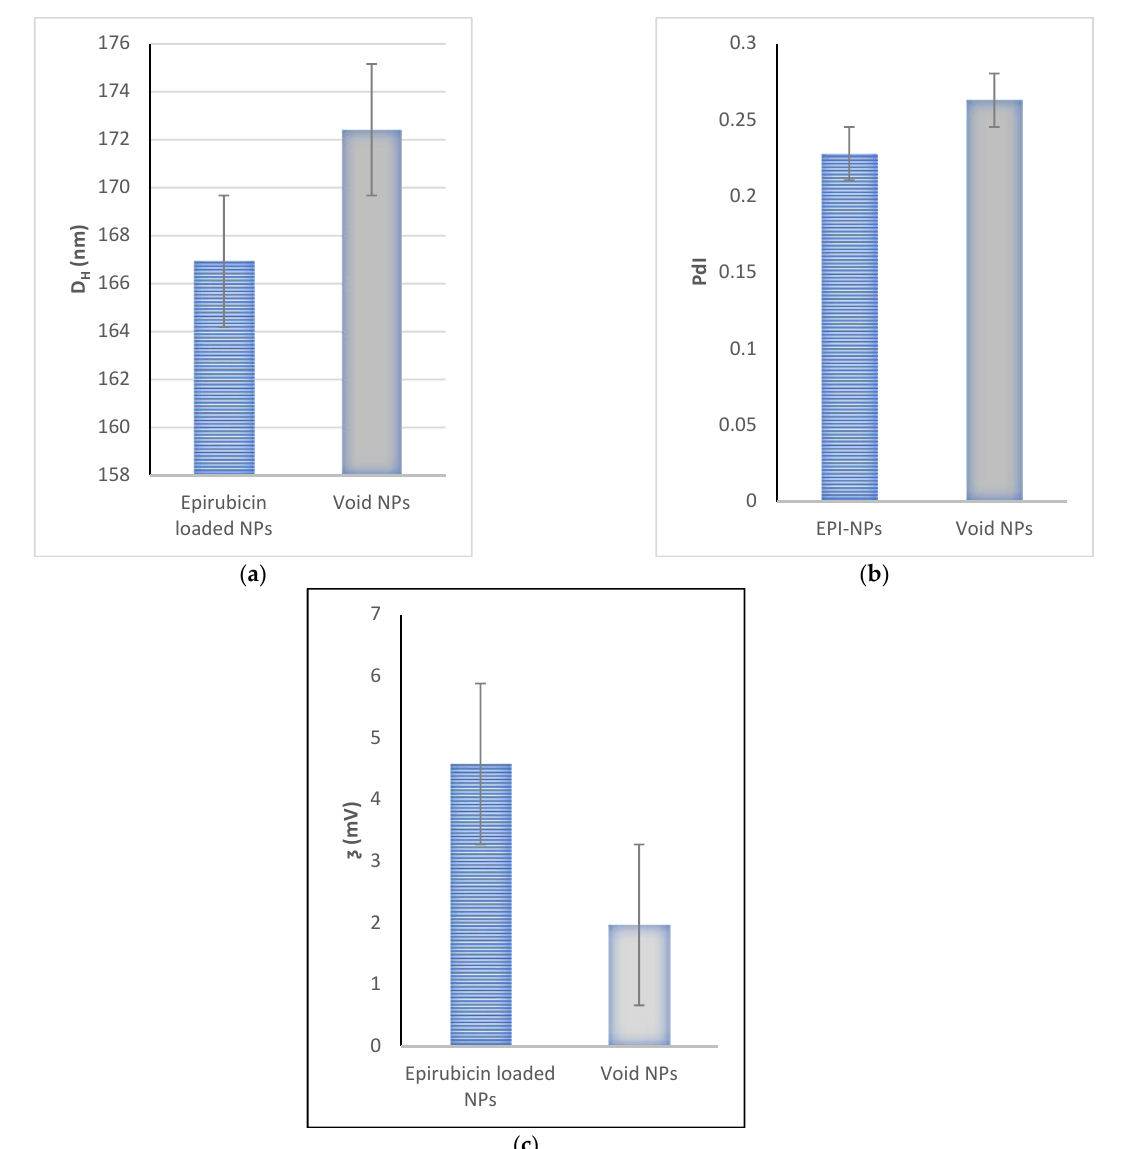
Figure 3. Mean ( a ) particle diameter, ( b ) polydispersity index and ( c ) zeta-potential for epirubicin-loaded NPs and void NPs. The data represent the mean average of the five instrument runs for each sample.